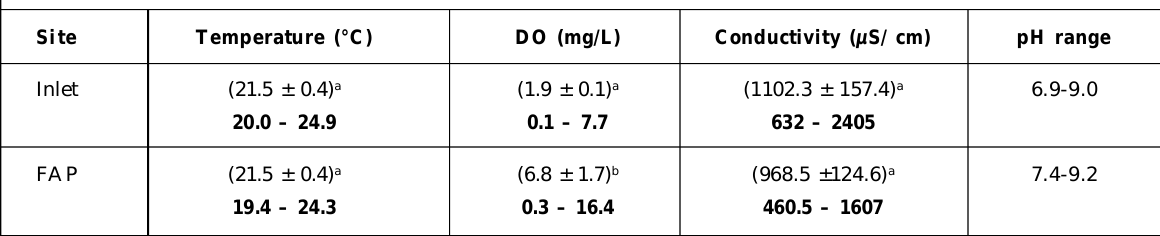
Table 1: Physical-chemical parameters of wastewater in